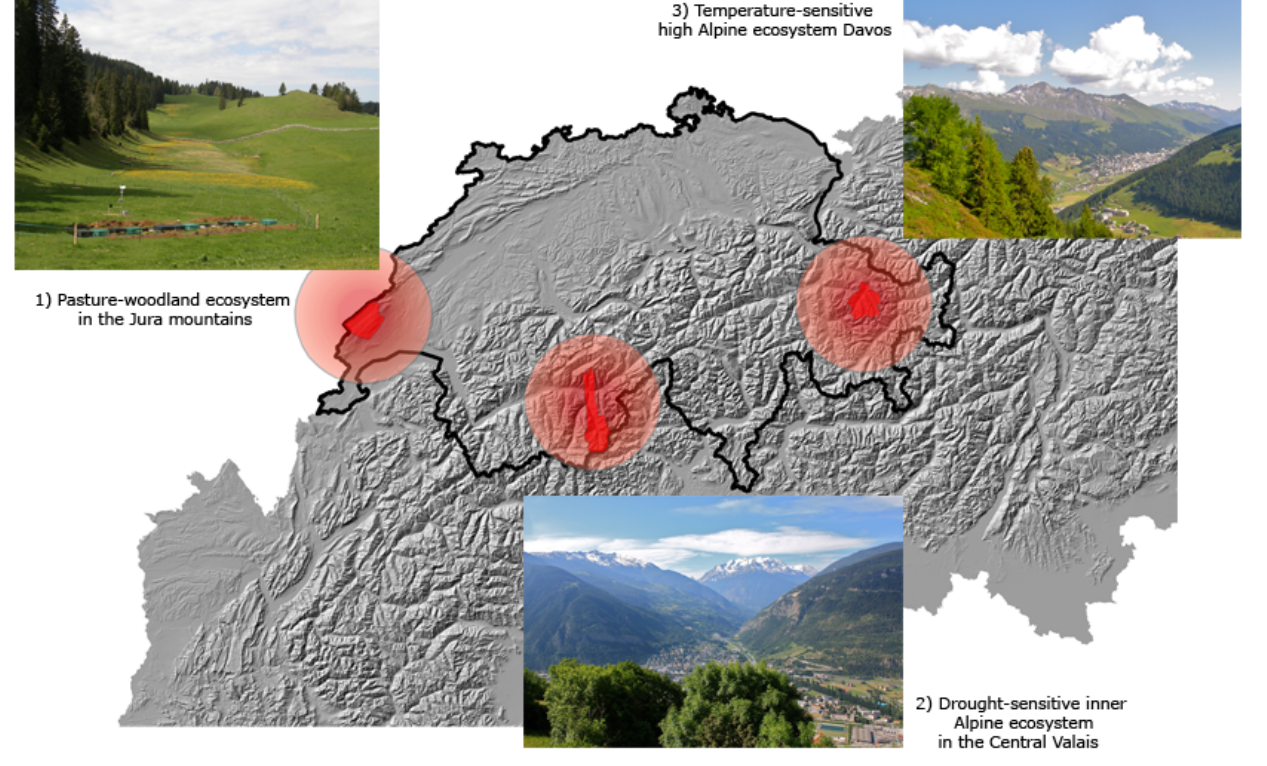
Fig. 1. Map of the European Alps and illustrative photographs of the three Mountland case study regions. Spatially explicit modeling focused on the core zones (opaque red). The circular areas (transparent red) indicate the areas of application, including the locations of some of the plot-scale experiments. Map produced by A. Psomonas, WSL. Photos: Alexandre Buttler and Andreas Rigling,